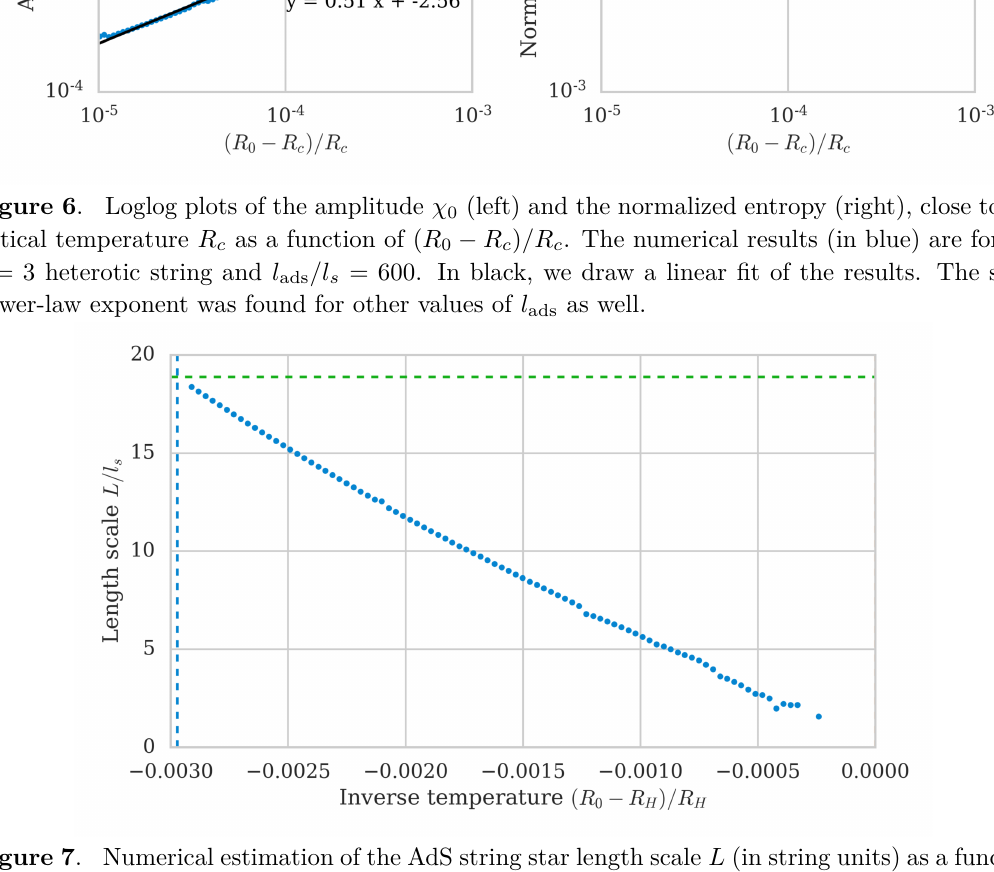
. The horizontal green line is the critical length c